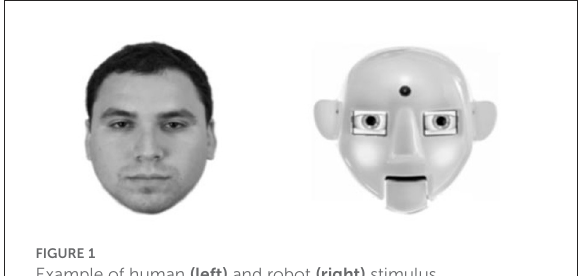
FIGURE1 Example of human (left) and robot (right)